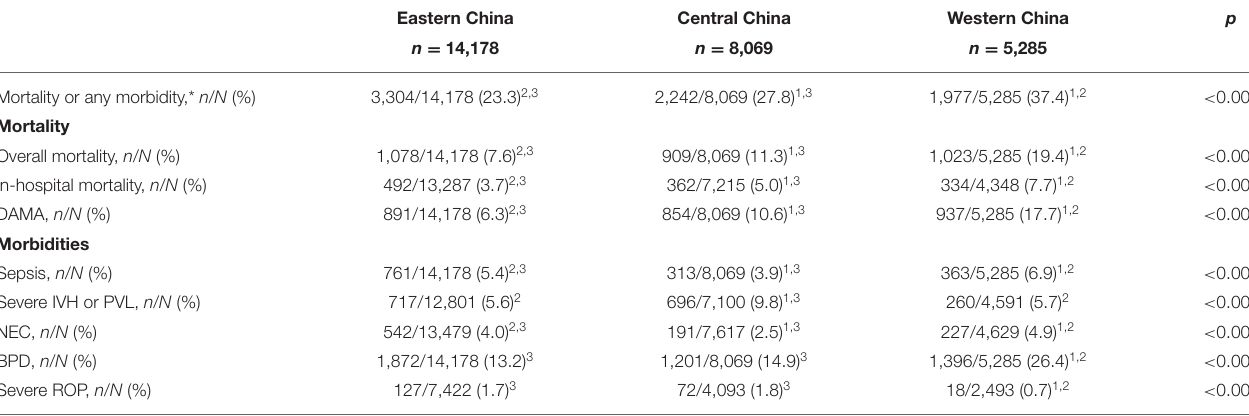
TABLE 2 | Comparison of unadjusted outcomes for preterm infants admitted to NICUs in three regions of China.